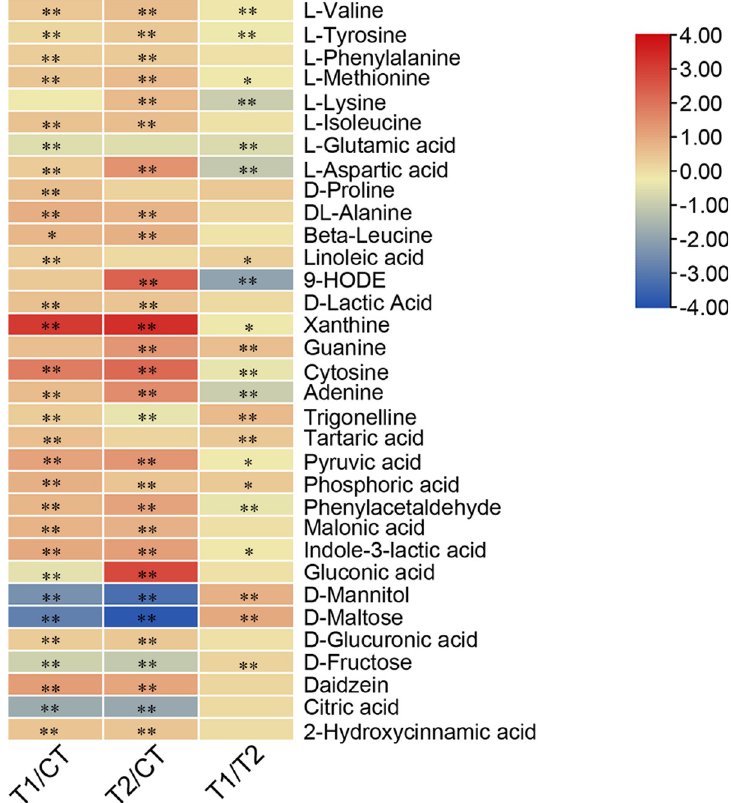
Fig 5. Identification of significant key metabolites by LC-MS in fermented food waste sample. The major metabolites were selected based on at least one of fold-change [log 2 (T1/CT), log 2 (T2/CT), log 2 (T1/T2)], in addition to exhibiting a statistically significant difference. � 0.001 < P < 0.05; �� P <